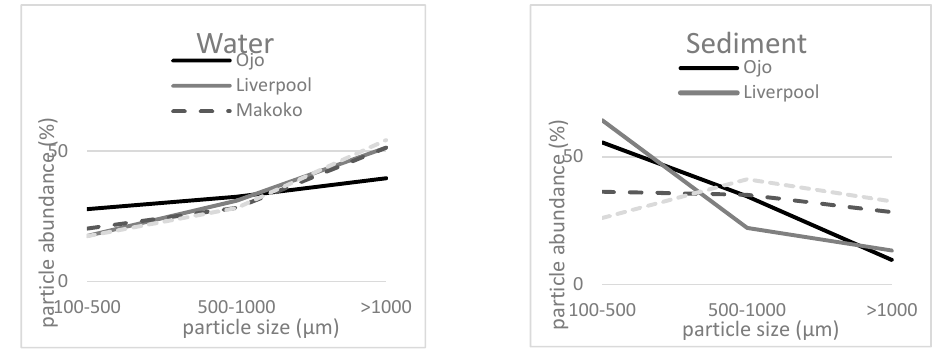
Figure 3. Form of microplastics in water and sediment samples (grey: fibre, black: foil, dashed line: fragment).